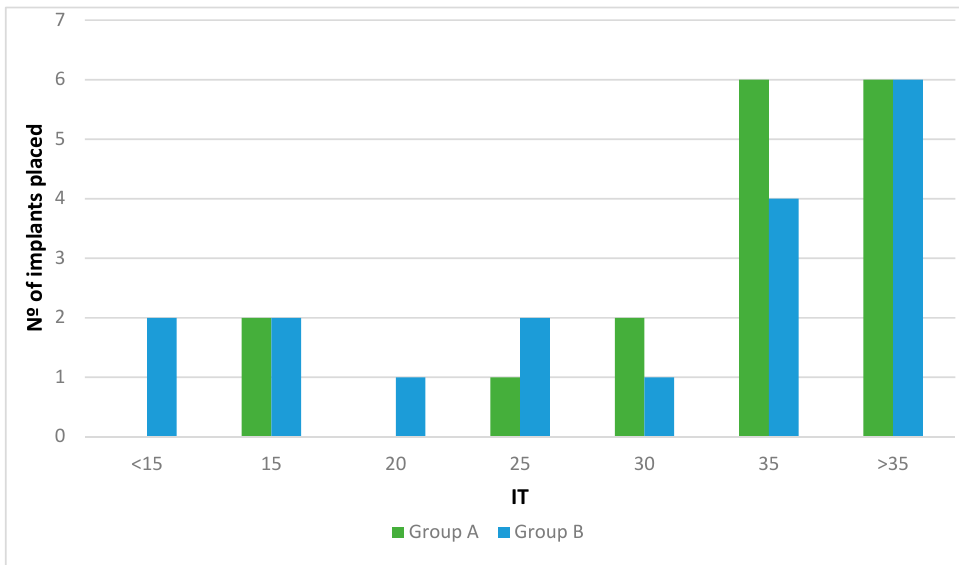
Figure 4. Insertion torque at implant placement.